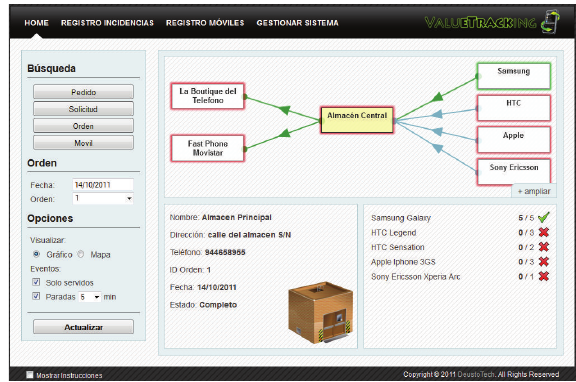
Figure 7: Management solution control panel web